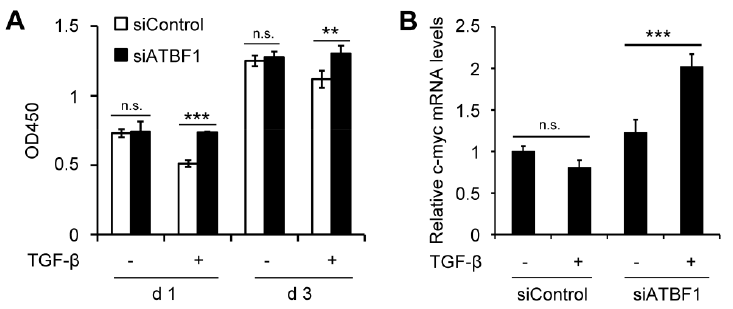
Figure 5. Knockdown of ATBF1 by siRNA rescued the inhibition of cell proliferation induced by TGF-β. ( A ) Cells were transfected with siControl or siATBF1 at 25 nM. Cell counting kit (CCK) was used to assay proliferation of cells with or without TGF-β treatment for one or three days. ( B ) The expression of c-myc (a key gene for cell proliferation) was measured by real-time qPCR. ** p < 0.01; *** p < 0.001; n.s., no significance. Triplicates were performed for each group.